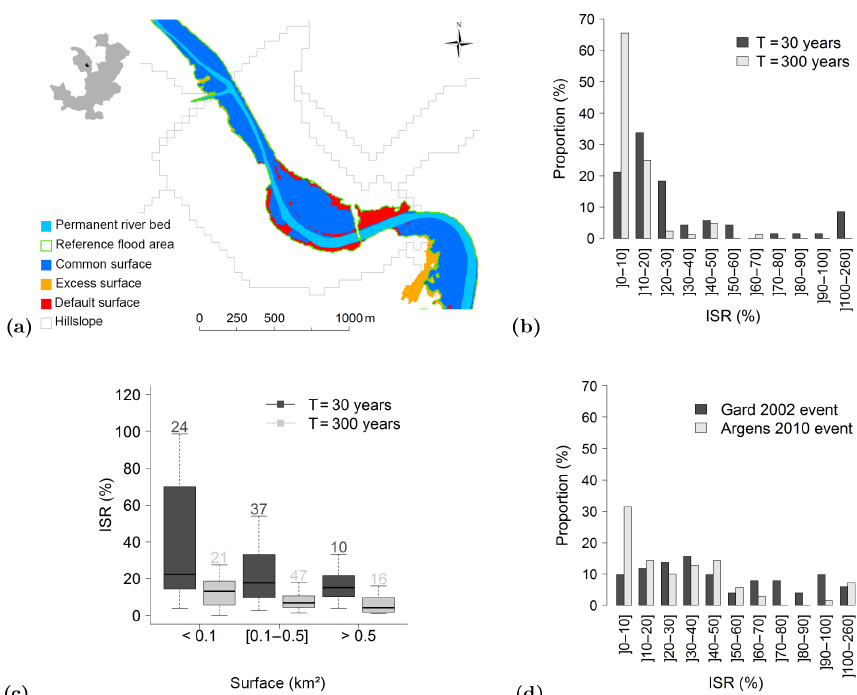
Figure 6. Comparison between estimated and reference flooded areas: (a) definition of common surface ( S c ), excess surface ( S e ), and default surface ( S d ) for the computation of ISRs, (b) distributions of ISR scores for the 30-year and 300-year discharge quantiles on the APSFR of Alès, (c) distributions of ISR scores depending on the extent of the reference flooded area, and (d) distributions of ISR scores for the full simulation chain for the Alès 2002 and Draguignan 2010